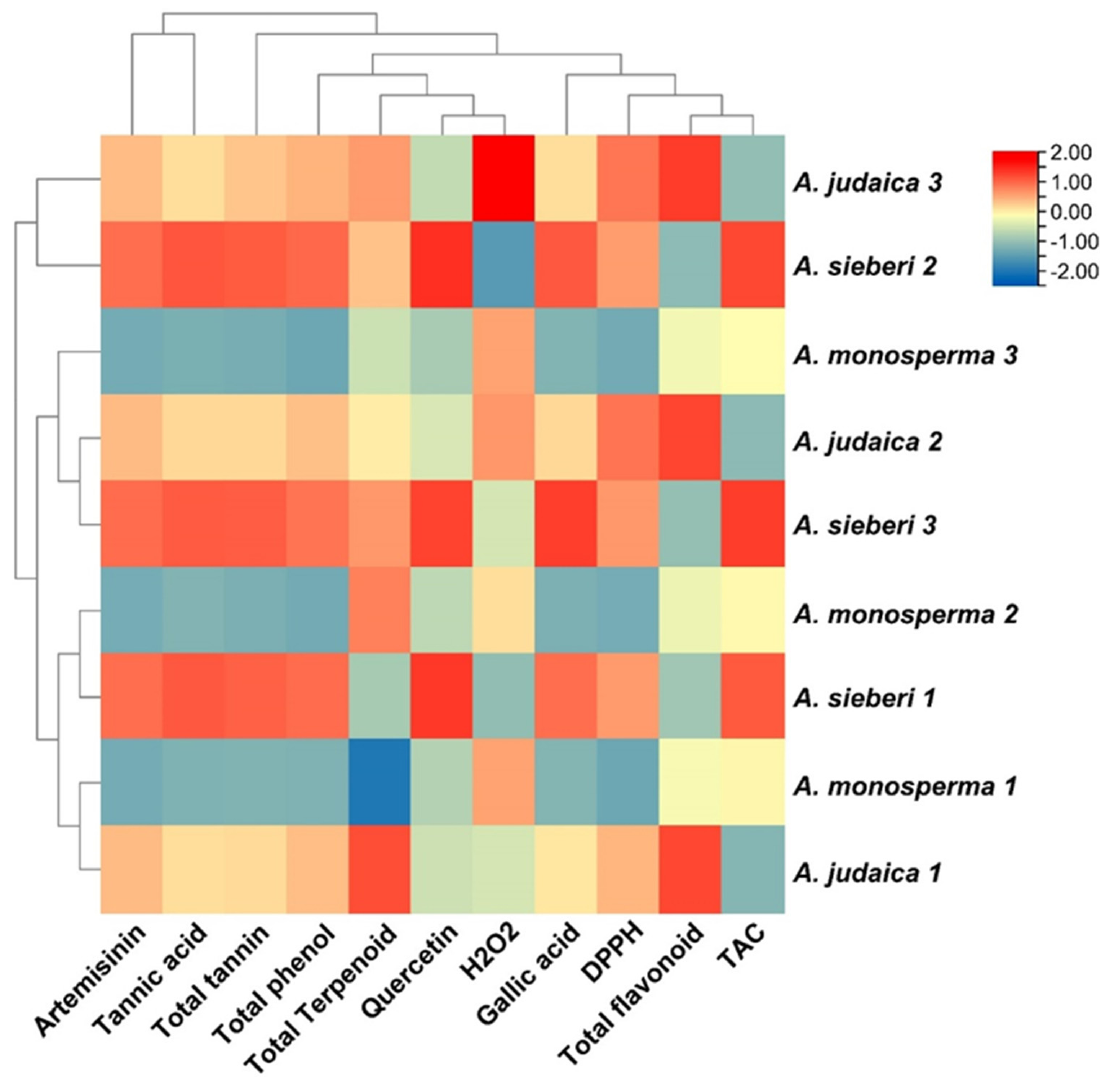
Figure 7. Heat map with cluster of phytochemical constituents from three Artemisia species ( A. judaica , A. monosperma , and A. sieberi ): showed identified levels of phytochemical components according to the colors from red to blue, demonstrated the level of bioactive constituents in decreasing order.